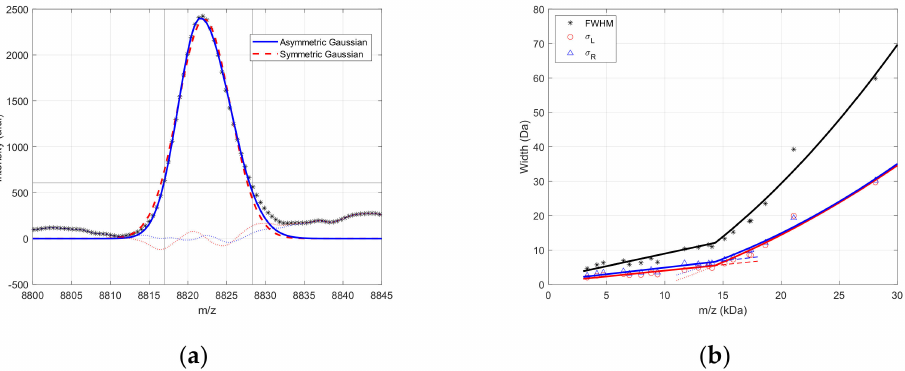
Figure 3. Peak shape determination of Bruker RapifleX MALDI-TOF spectral peaks. ( a ) Raw sample data (black stars) and peak fit to an asymmetric (blue-solid) and symmetric (red-dashed) Gaussian. Fit error is shown by the dotted lines. ( b ) Peak shape parameters as a function of m/z. Overall fitted trend is shown with solid lines and the linear (dashed) and quadratic (dotted) piecewise portions for σ L and σ R of the fits are extended past the trend range for reader